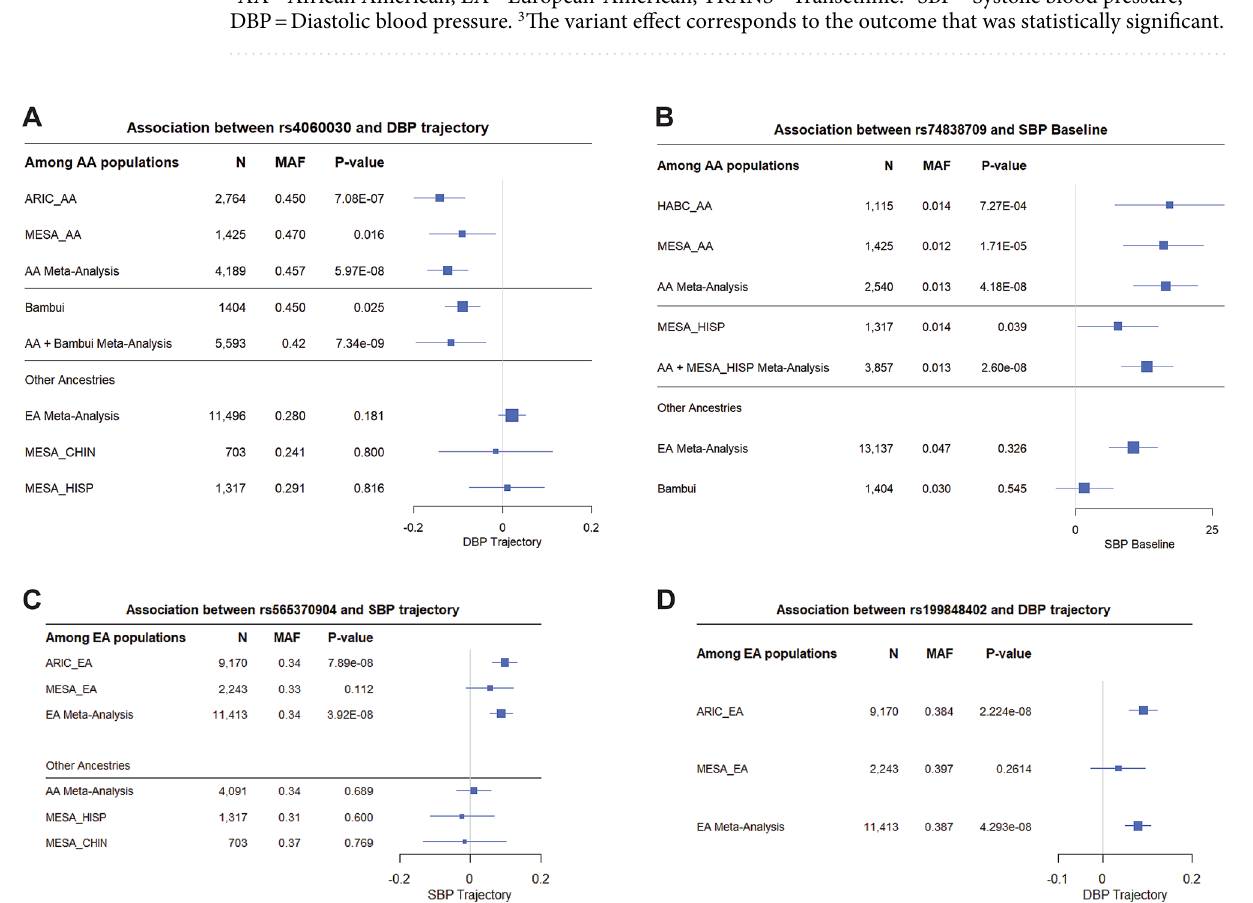
associations, we present the statistical significance for the three outcomes analyzed: trajectory, average, and baseline (Table 2 and Table S1). We found 19 loci that were significantly (or borderline) associated with BP outcomes (Table 2, Tables S1–S4, Fig. 1 and Figs. S3–S10), of which 14 were significantly associated and five were borderline significantly associ- ated. Out of these 19 loci, 10 were associated with longitudinal outcomes and nine with baseline. Of these 19 loci, 17 were ethnic- or study-specific, with the majority (11) found in African Americans (AA). We observed significant heterogeneity across studies (ethnic-specific meta-analyses) or ethnicities (trans-ethnic meta-analyses) for only one locus in AA populations (Table S2). This variant (rs145522449) showed significant heterogeneity